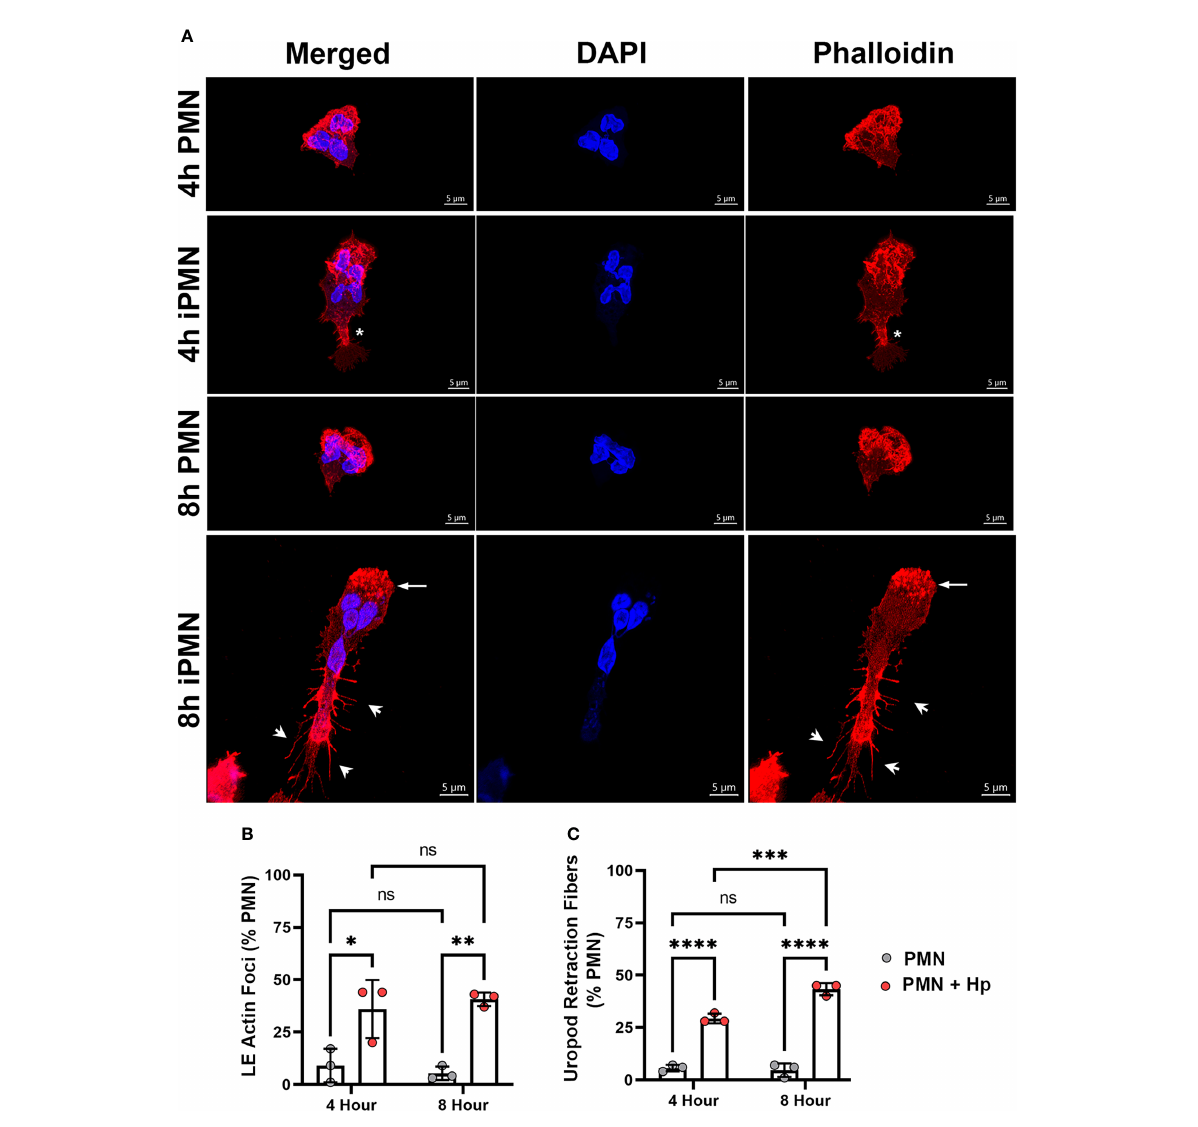
FIGURE 3 Infected PMNs display progressively modi fi ed actin localization during migration. (A) Images are 3D confocal Z-stacks of control and infected cells migrating toward fMLF in MatTek ™ dishes assayed at 4 and 8 hours. Fixed cells were double-stained to detect DNA (DAPI, blue) and F- actin (rhodamine-phalloidin, red). Asterisks indicate an area of F-actin enrichment behind the nucleus of a 4 hour iPMN. Arrows and arrowheads indicate actin foci at the leading edge and actin-rich spikes/retraction fi bers decorating the elongated uropod of an 8 hour iPMN, respectively. Images are representative of three independent experiments. Scale bar = 5 m m. iPMN, infected PMN. (B, C) Pooled confocal data indicate the percentage of uninfected and H . pylori -infected PMNs that exhibited enhanced leading edge (LE) F-actin foci (B) , F-actin-rich retraction fi bers at the rear uropod (C) . At least 100 cells/experiment/condition were scored. Data are the mean ± SD from three independent experiments. Data were analyzed by two-way ANOVA and Tukey ’ s multiple comparisons post-test. * p <0.05, ** p <0.01, *** p <0.001, **** p <0.0001, ns, not signi fi cant, as indicated. Hp, H . pylori